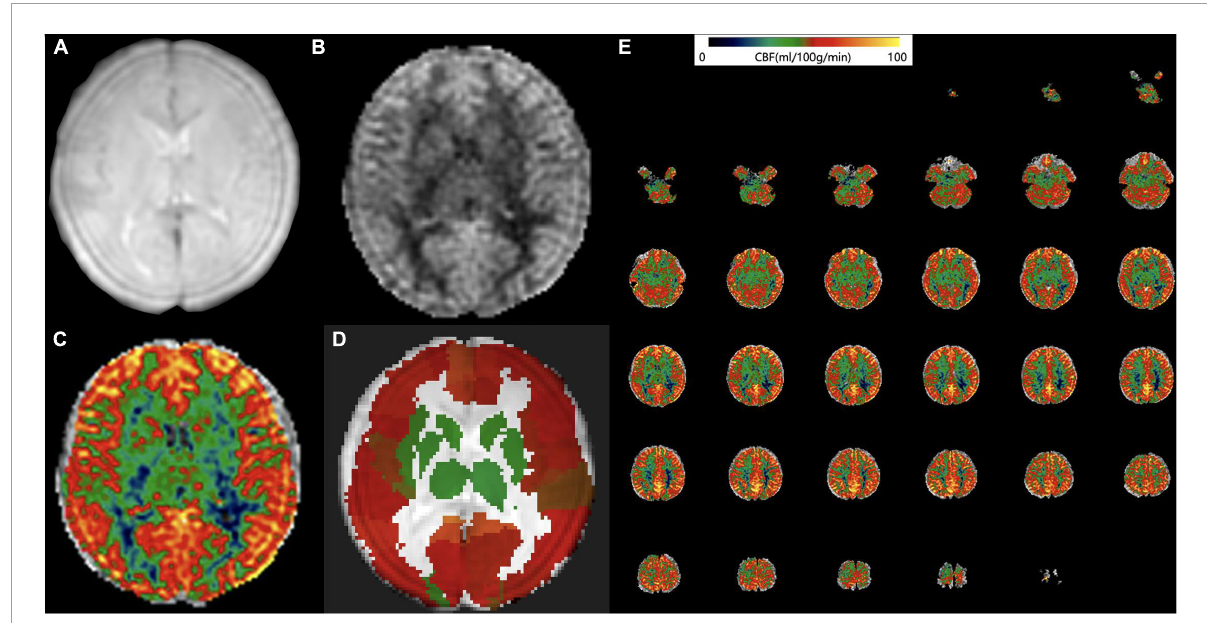
FIGURE1 Arterial spin labeling (ASL) data processing workflow. Convert the (A) 3D ASL proton density images and (B) perfusion weighted images into the cerebral blood flow (CBF) map of cerebral perfusion for each participant. (C) The CBF map was normalized to the Montreal Neurological Institute (MNI) space and then the Automated anatomical labelling (AAL) atlas was overlaid. (D) The average CBF value of each brain region from AAL atlas was obtained. (E) An example CBF map of a four-year old male ASD patient calculated by Cereflow software.